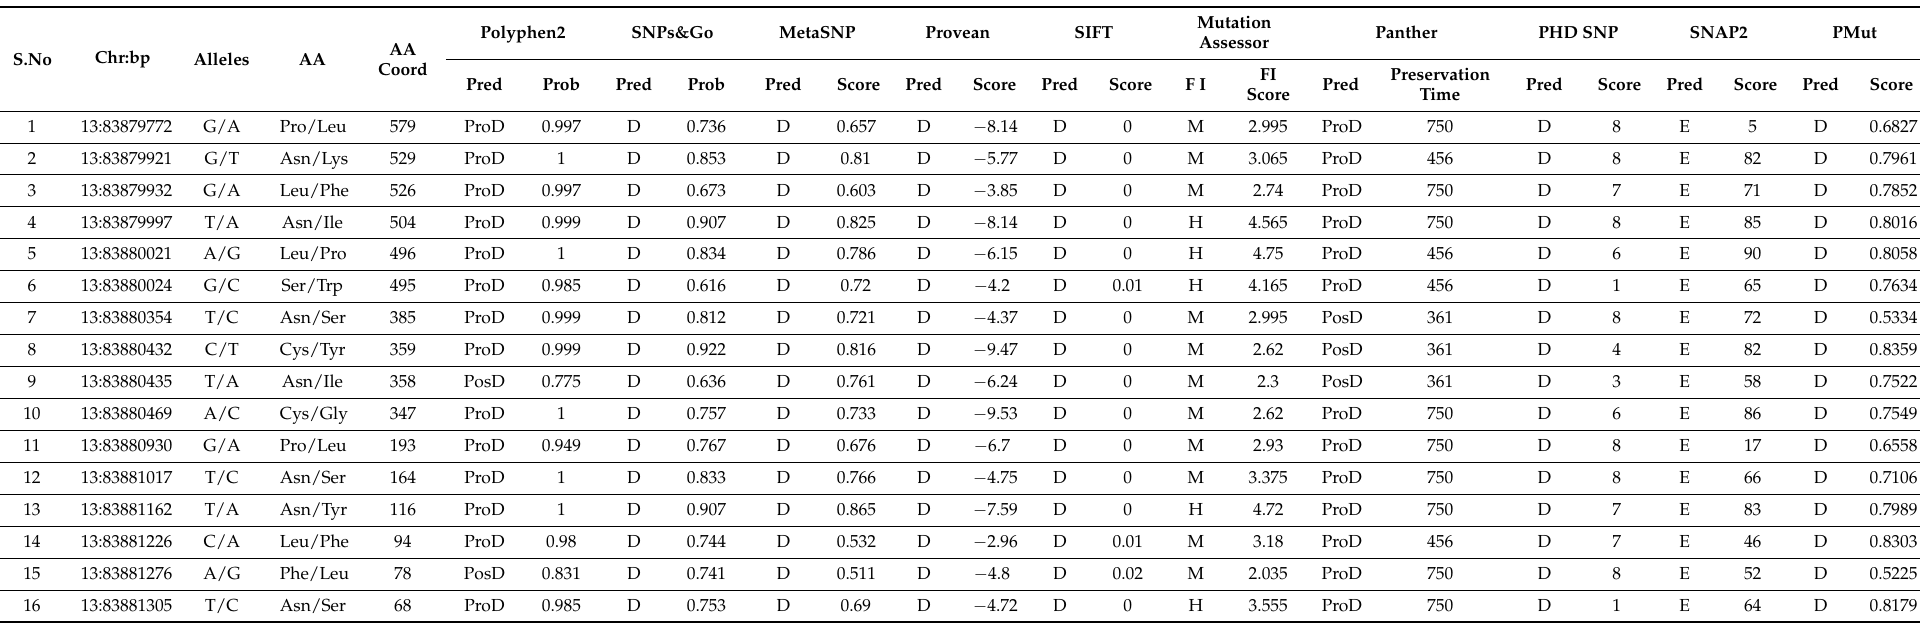
Table 1. List of variants commonly predicted to be pathogenic by all